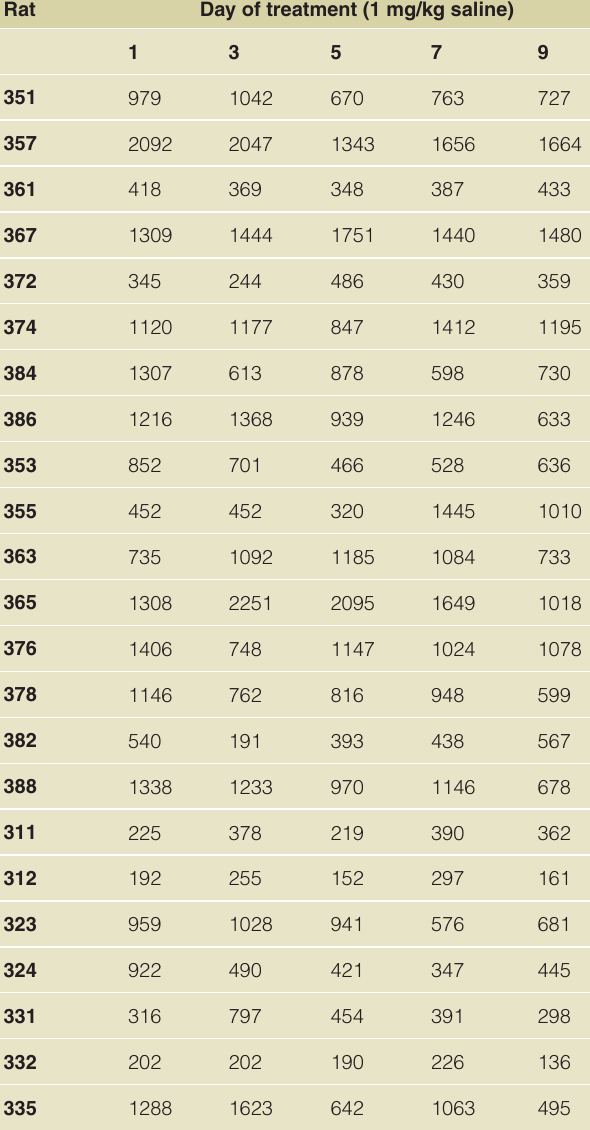
Table S4. Fenobam experiment – locomotor response (total quarter turns over 90 min) after saline treatments. In locomotor significantly change from first-day